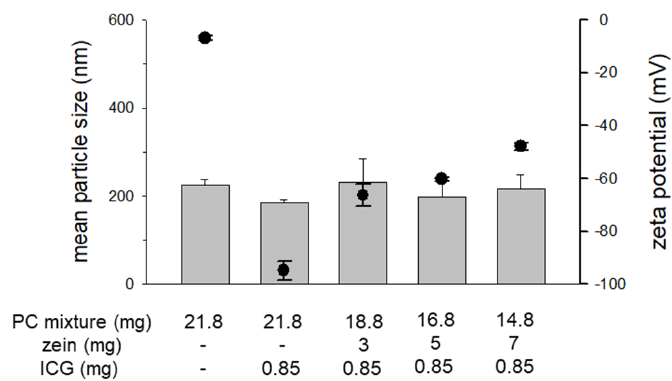
Figure 2. The effect of the zein-to-PC ratio on the mean particle size and the zeta potential of Z/PC-NP. The closed circle symbols indicate the zeta potential and the bars indicate the mean particle size.